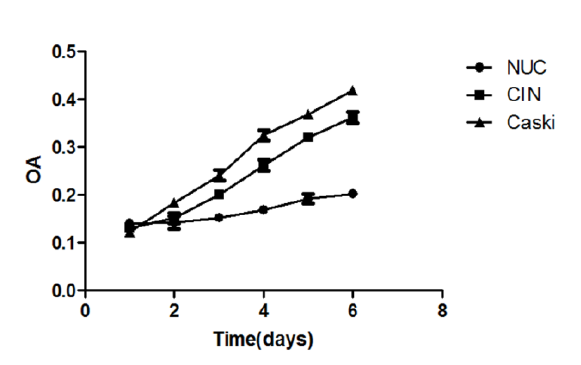
Figure 1: Measurement of cell growth curves with